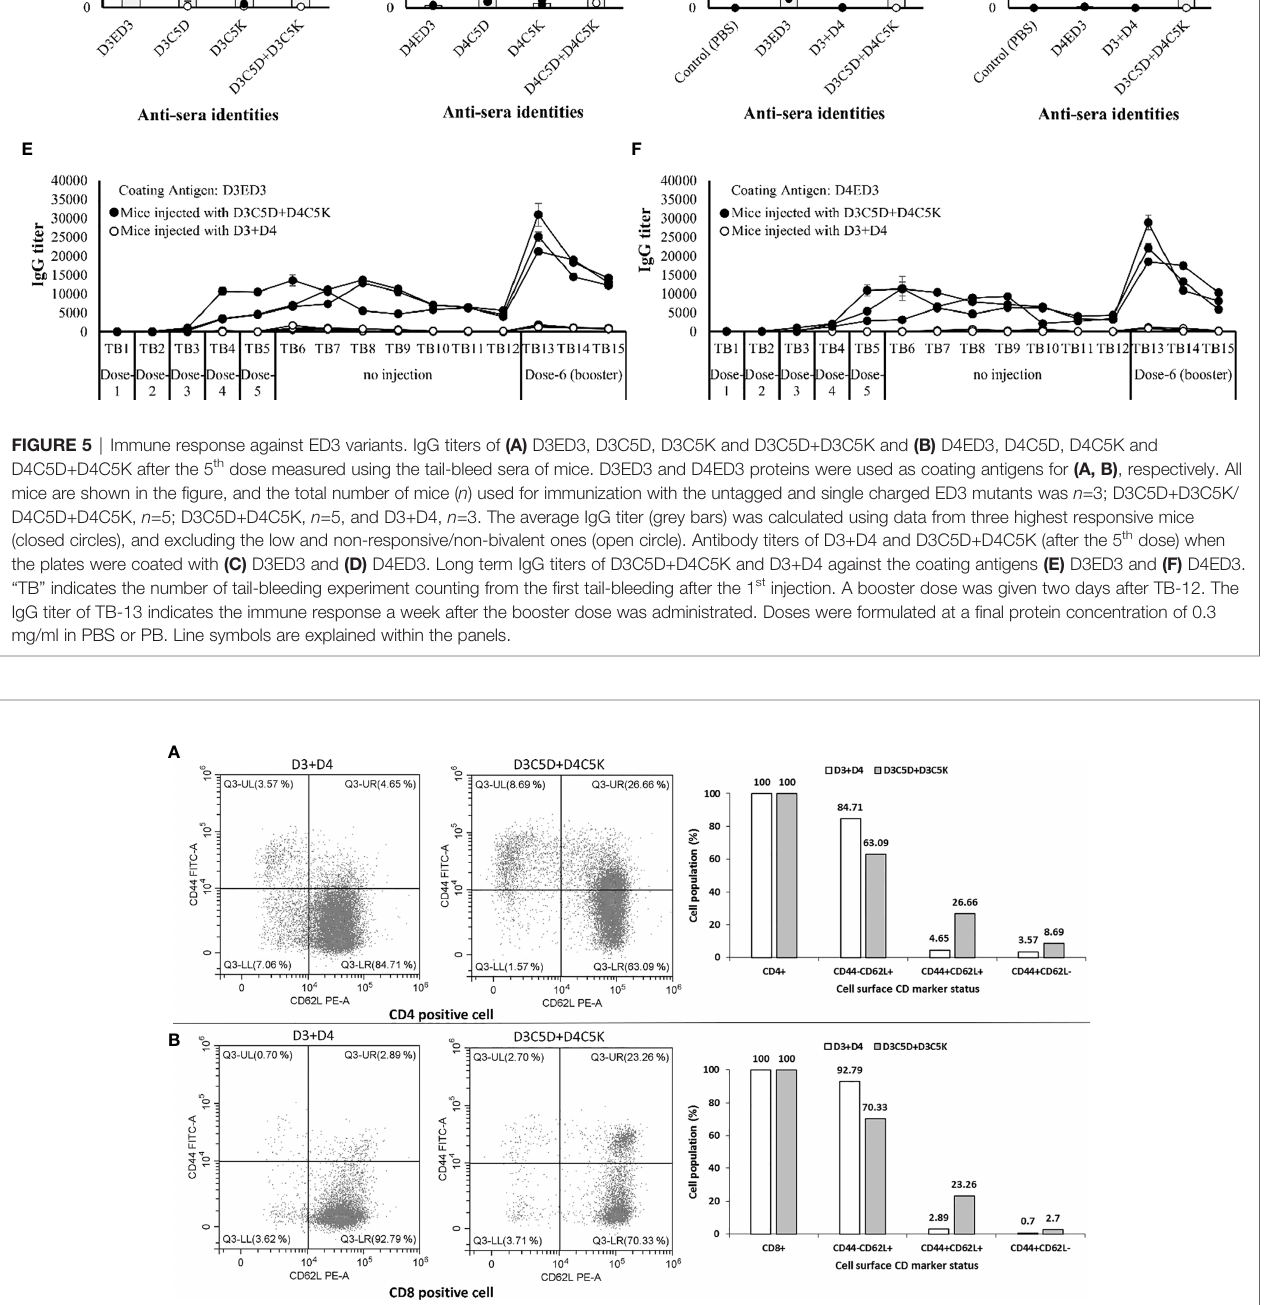
FIGURE 6 | Flow cytometric analysis of the cell surface CD marker. Single cell suspension of splenocytes (obtained from a randomly selected mouse out of three that induced bivalent immune response) was used for fl ow-cytometry analysis by formulating into FACS buffer. Co-expression pattern of CD44 and CD62L on T- helper cell (CD4 positive) and T-cytolytic Cell (CD8 positive are shown in panel (A, B) , respectively. Heterotypic oligomer of tagged ED3 (D3C5D+D4C5K) induced higher proportion of CD44+CD62L+ and CD44+CD62L- co-expressed cells than that of the untagged mixture of ED3